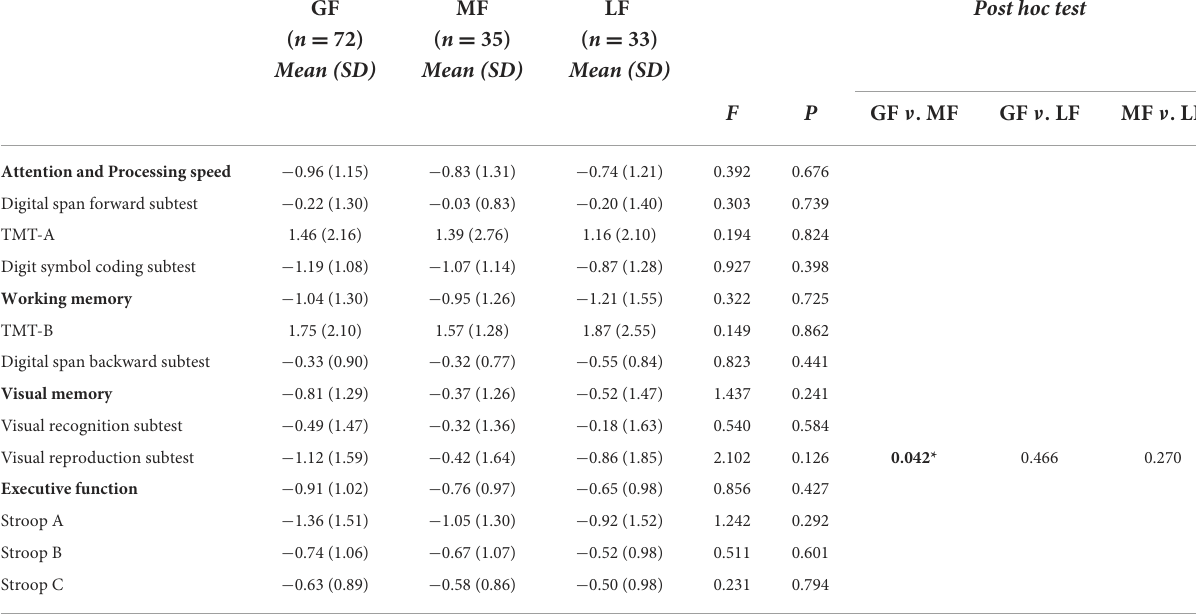
TABLE 4 Comparisons between three functional clusters on neurocognitive variables